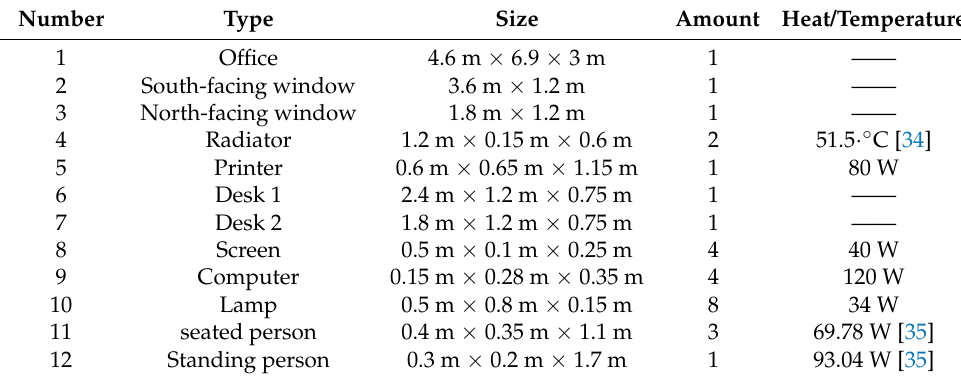
Figure 5. The 3D model and detailed mesh: ( a ) computational model; ( b , c ) drawing of partial en- largement.